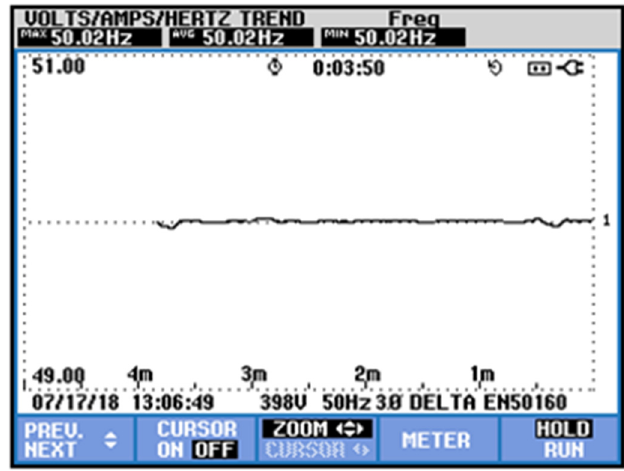
Figure 12. Frequency results in the AC offshore link grid—CIS control.